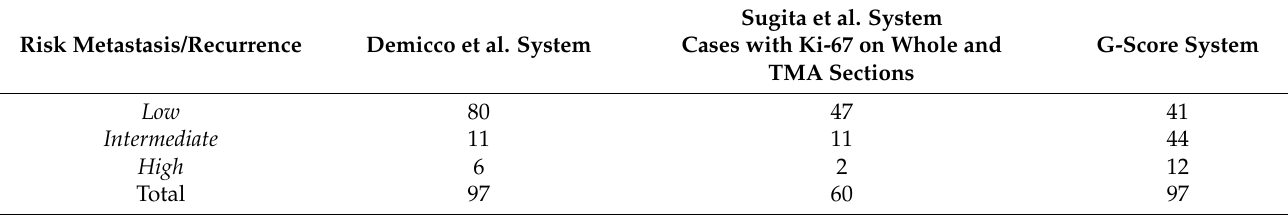
Meier survival curve using Demicco and G-score RSS are shown in Scheme 3. Table 1. Distribution of risk of recurrence and/or metastasis between the three RSS in the present series.